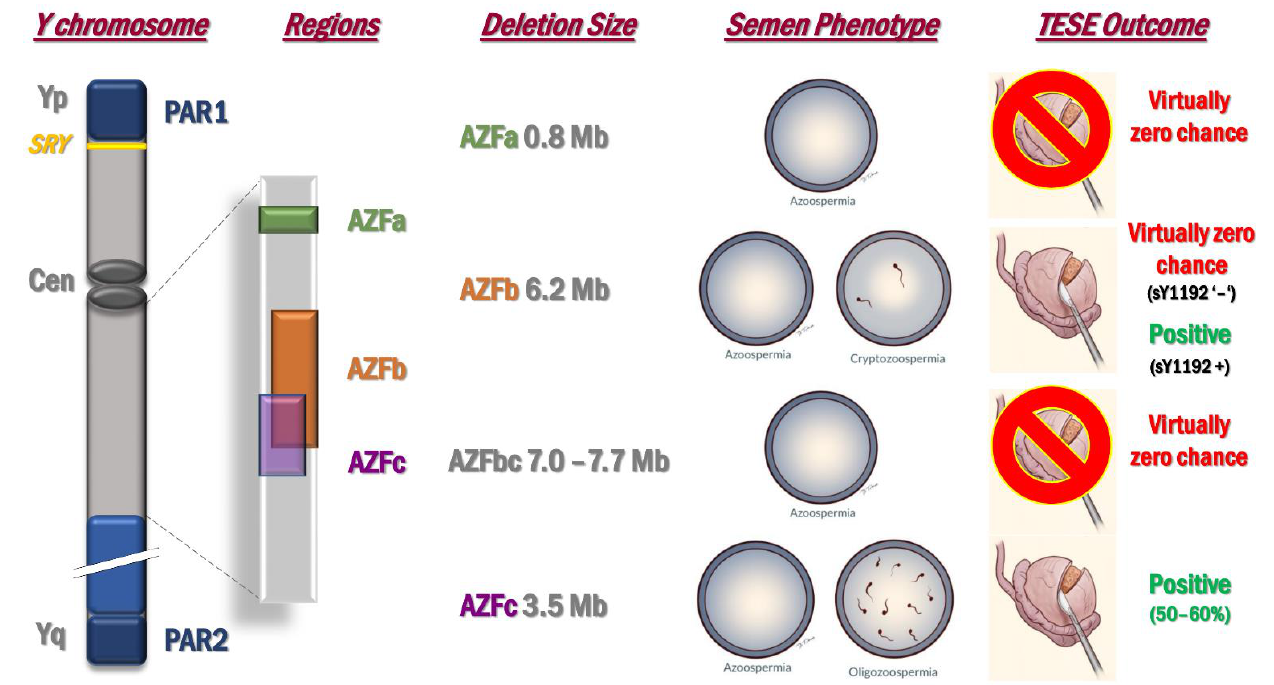
Figure 2. Semen phenotype and TESE outcomes of the different types of AZF microdeletion. Abbreviations: AZF—Azoospermia Factor Region; Cen—centromere; PAR1—Pseudoautosomal Region 1; PAR2—Pseudoautosomal Region 2; SRY —Sex-determining Region Y gene; TESE—Testicular Sperm Extraction.